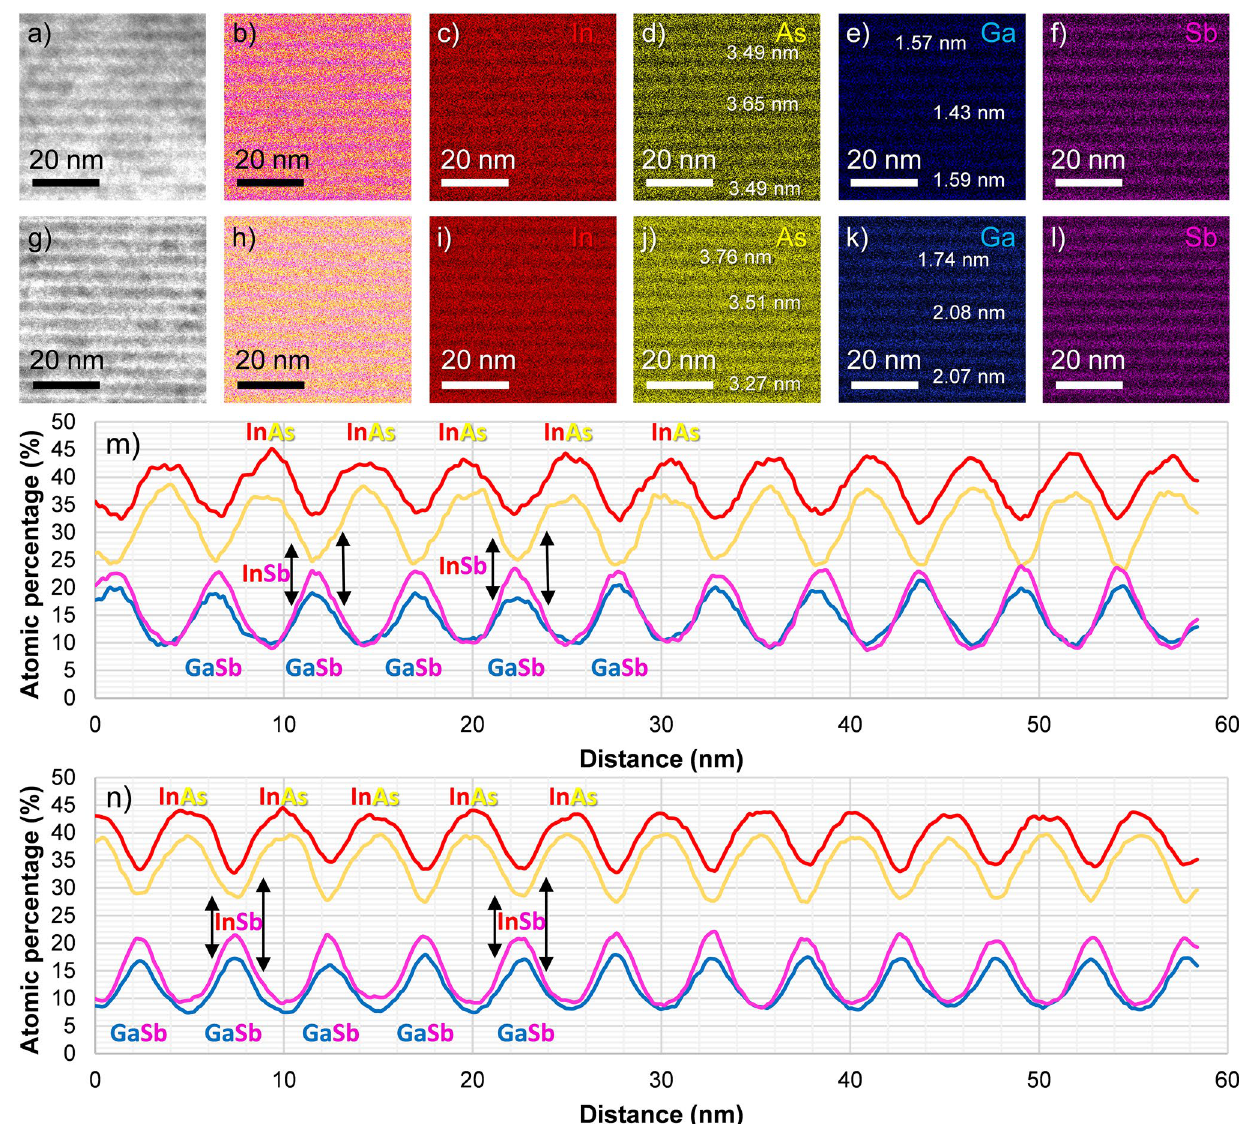
Figure 4. For Samples A ( a )-( f ) and B ( g )-( l ) and from left to right: STEM-HAADF image from a region around the middle layers of the T2SL, spectrum image combining atomic percentage maps by In, As, Ga, and Sb and individual maps for each element, including some thickness measurements. EDX integrated atomic percentage spectrum profiles registered from the bottom to the top of the mapped areas shown after filtering them, in Sample A ( m ) and B ( n